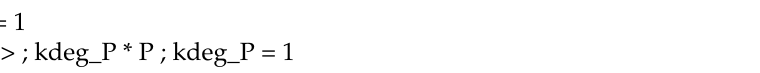
Figure 2. Overview of KinModGPT.